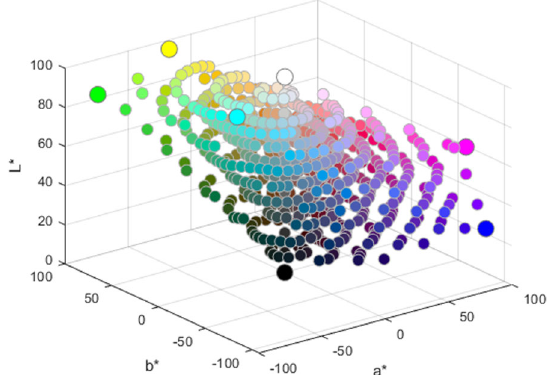
Fig. 2 Stimuli in the color ‐ naming experiment constrained by the sRGB gamut and plotted in CIEL*a*b* space. Enlarged circles denote eight color samples at the corners of the sRGB